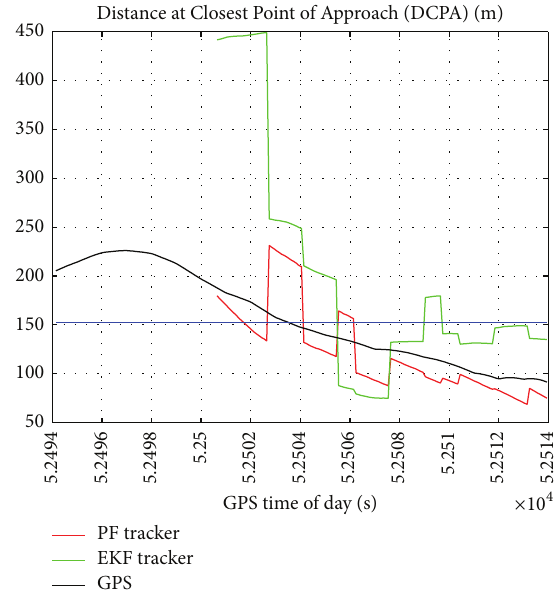
Figure 11: Distance at Closest Point of Approach as estimated by GPS (reference), by radar, and by radar-only tracker as function of GPS time of the